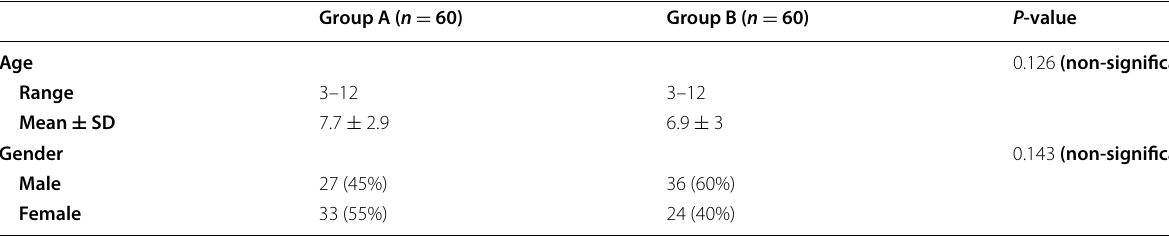
Table 1 Comparison between both groups regarding patients’